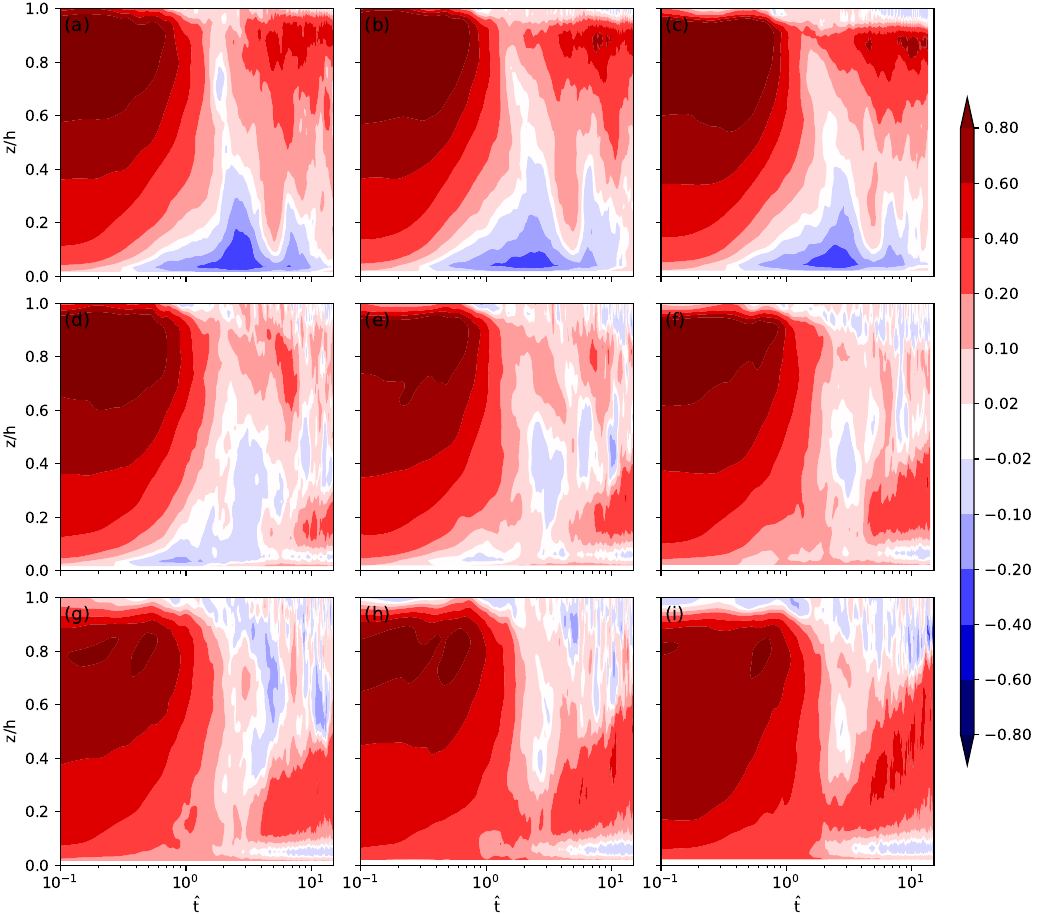
Figure 9. Time series of vertical profiles of vertical velocity skewness in the ( a ) B3, ( b ) B2, ( c ) B1, ( d ) I3, ( e ) I2, ( f ) I1, ( g ) S3, ( h ) S2, and ( i ) S1